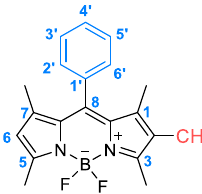
Figure 1 . Structure of BODIPY derivative 2 . Figure 1. Structure of BODIPY derivative 2